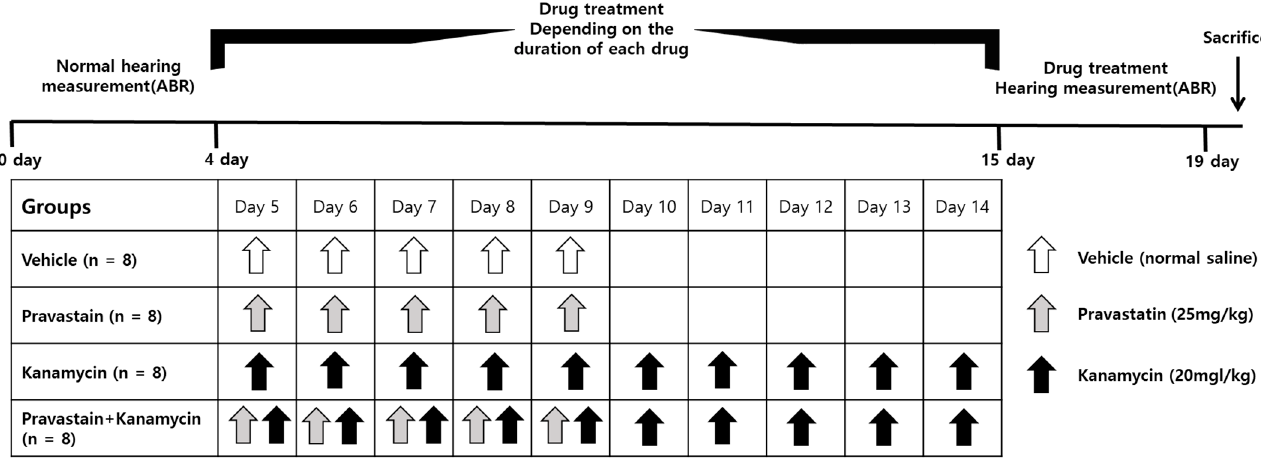
Figure 5. Flow chart of the experiments. Adult rats (8–11 week Sprague–Dawley rats, 200–250 g) were classified into the vehicle, pravastatin (PV), kanamycin (KM), and PV + KM groups ( n = 8 per group). Rats in the KM group were administered KM (20 mg/kg/day) i.p. for 10 days. Rats in the PV group were administered PV (25 mg/kg/day) i.p. for 5 days. The rats in the PV + KM group were injected with 25 mg/kg/day of PV and 20 mg/kg/day of KM i.p. for the first 5 days, and then with 20 mg/kg/day of KM for 5 days.